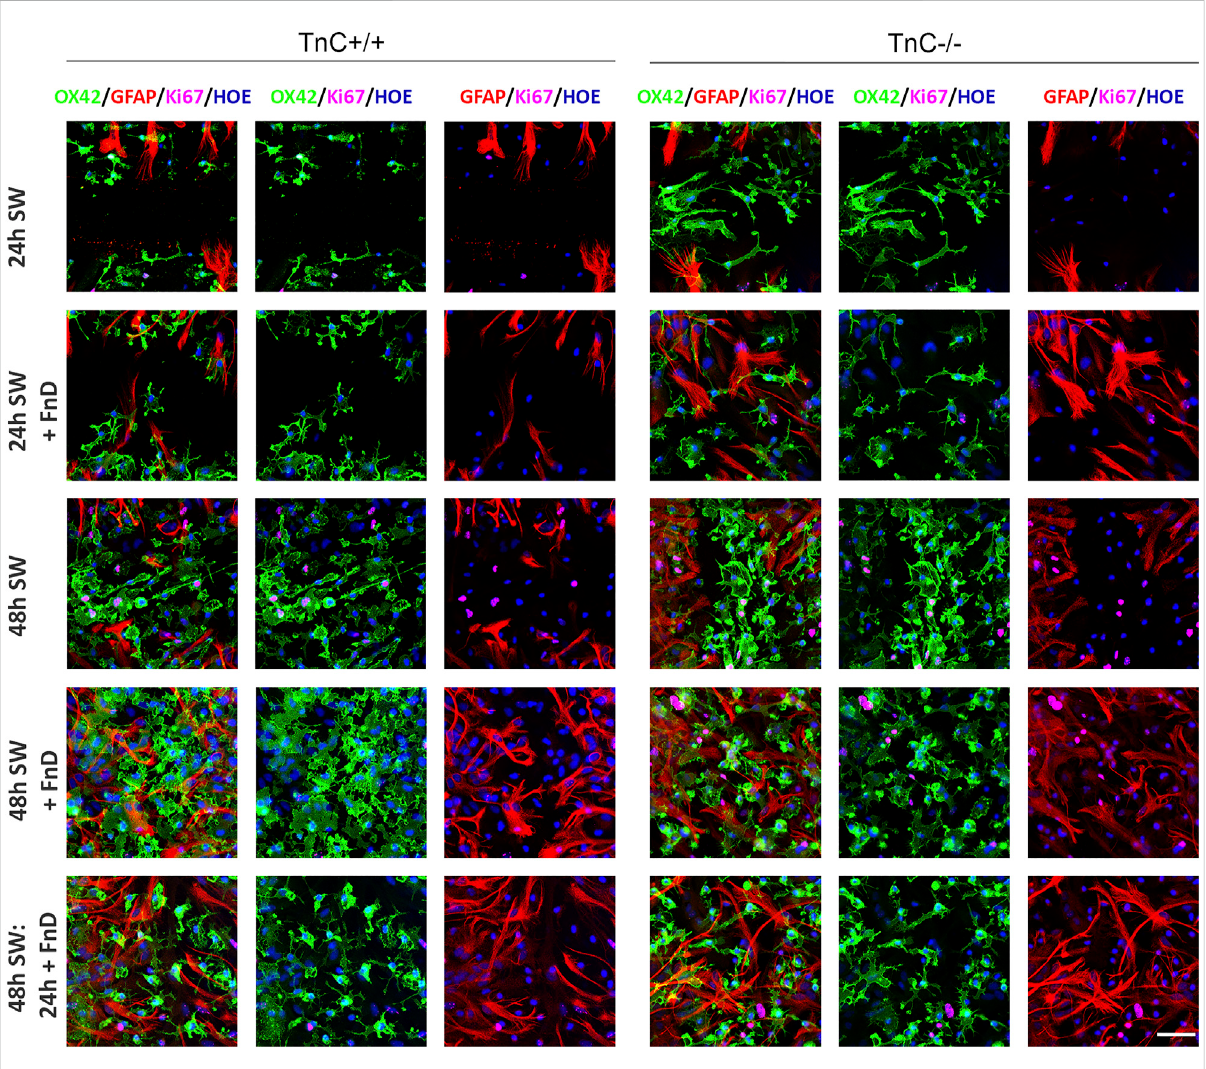
FIGURE 2 Representative micrographs of gap area depicting different densities and proliferation rates of microglia and astrocytes per treatment and genotype.Confocal imagesofimmuno fl uorescentlylabelledmicroglia(OX42,green),astrocytes(GFAP, red)proliferatingnuclei(Ki67,magenta) and nuclei (Hoechst, blue) within the gap area of SW per treatment/genotype. Sale bar: 50